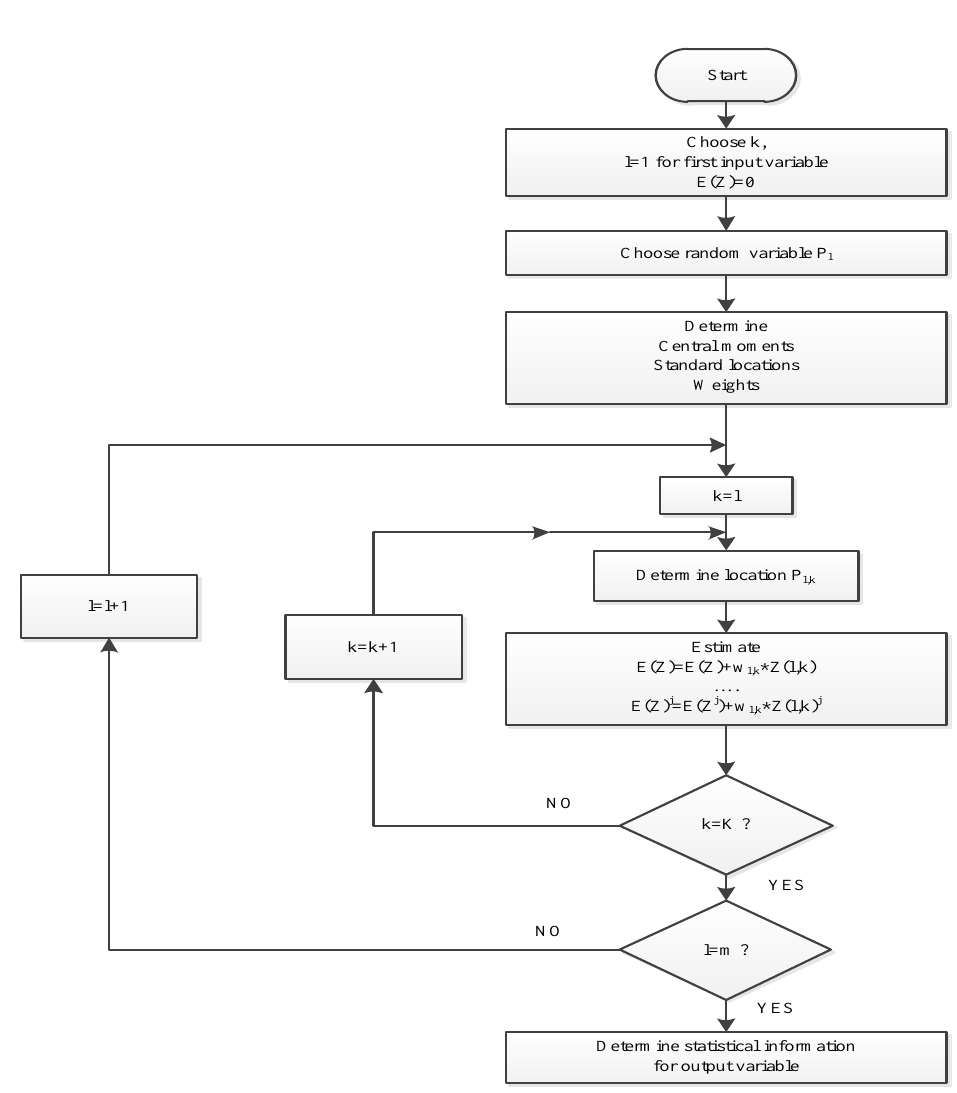
Figure 1. Flow chart for probabilistic load flow considering point estimate method.